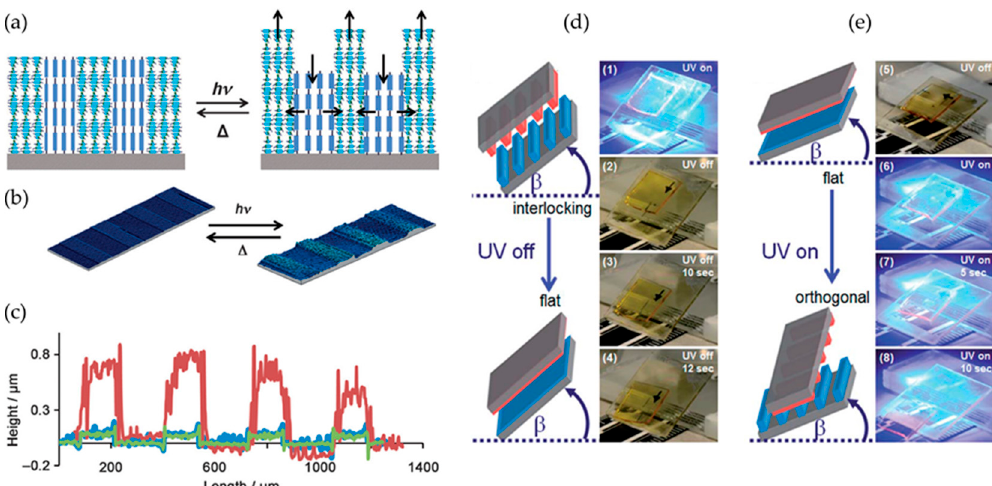
Figure 11. ( a ) Graphical illustration of the patterned coating with resulting influence of light; ( b ) 3D images of the coating in the absence and presence of light with different heights ( c ). Reproduced from [94]; ( d , e ) The slide-off of two pattern coated glass slides in contact and balanced at an angle ß under the influence of UV light. The samples are positioned parallel ( d ) and orthogonal ( e ) with respect to one another, leading to different slide-off properties and friction. Reproduced from [101].